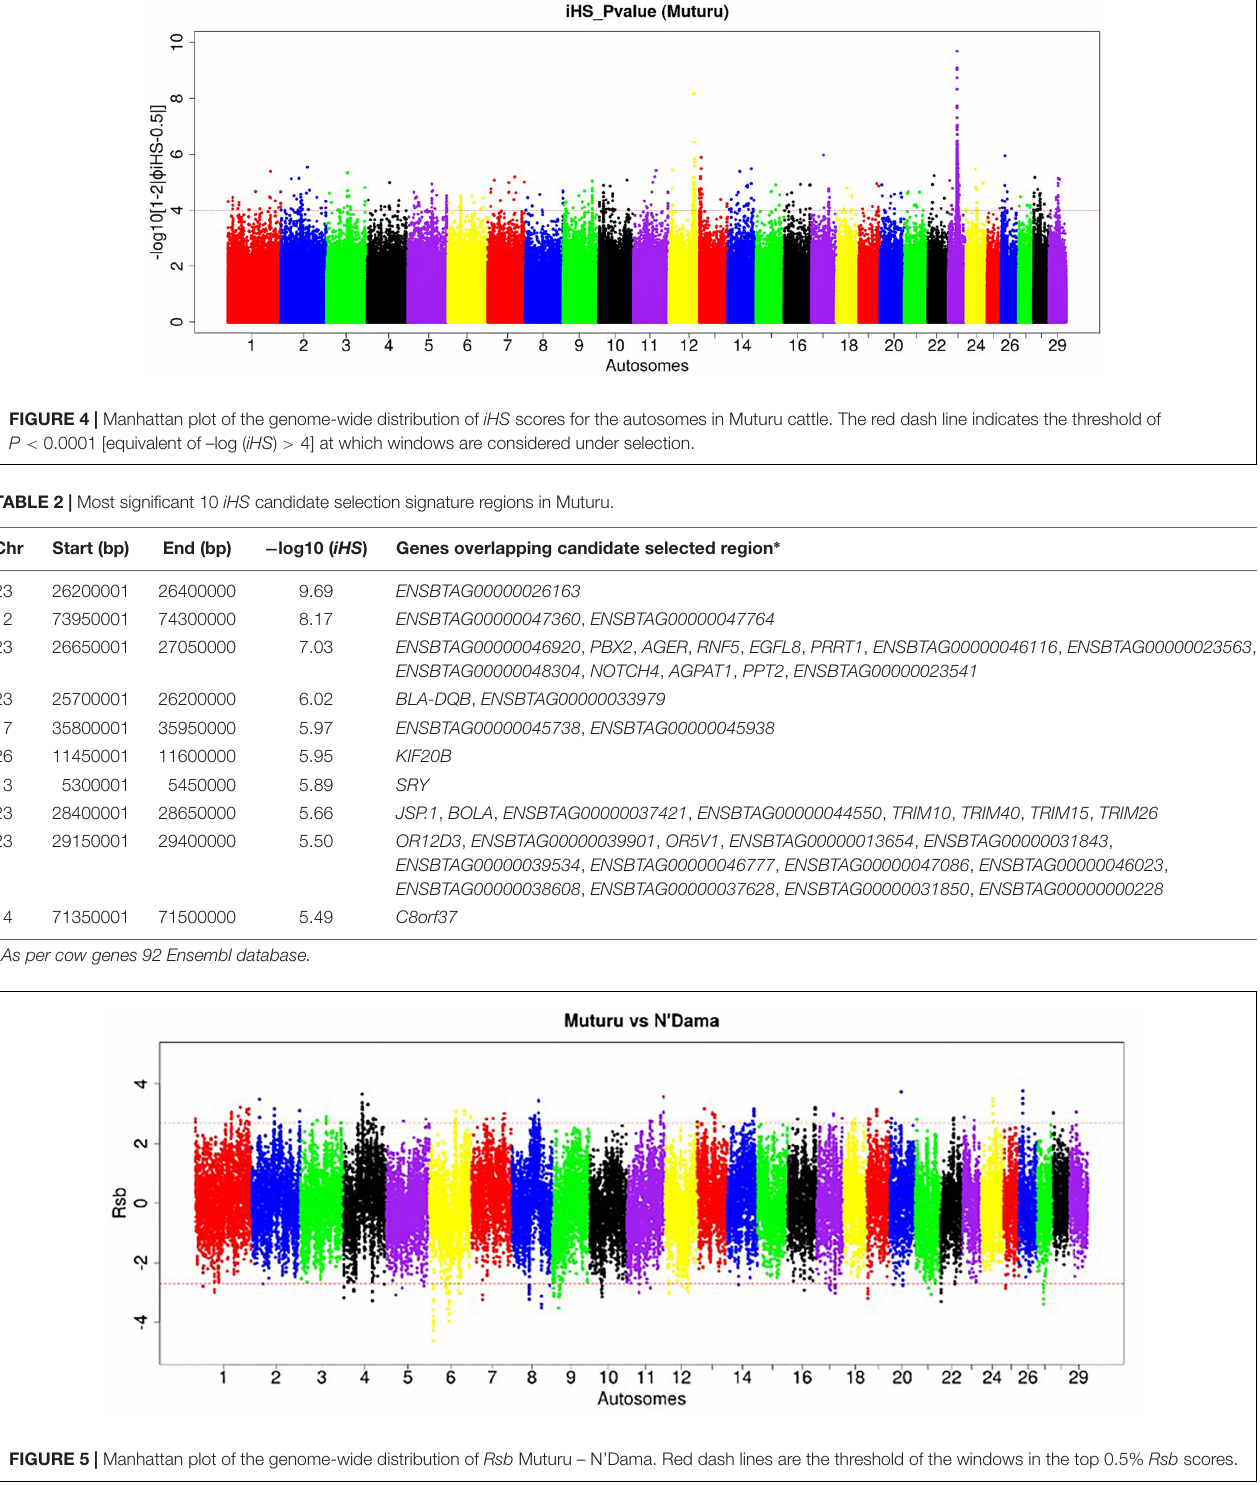
population ( iHS ) and between them ( Rsb ). The distributions of these genome-wide iHS and Rsb scores are presented in Supplementary Figures S1–S6